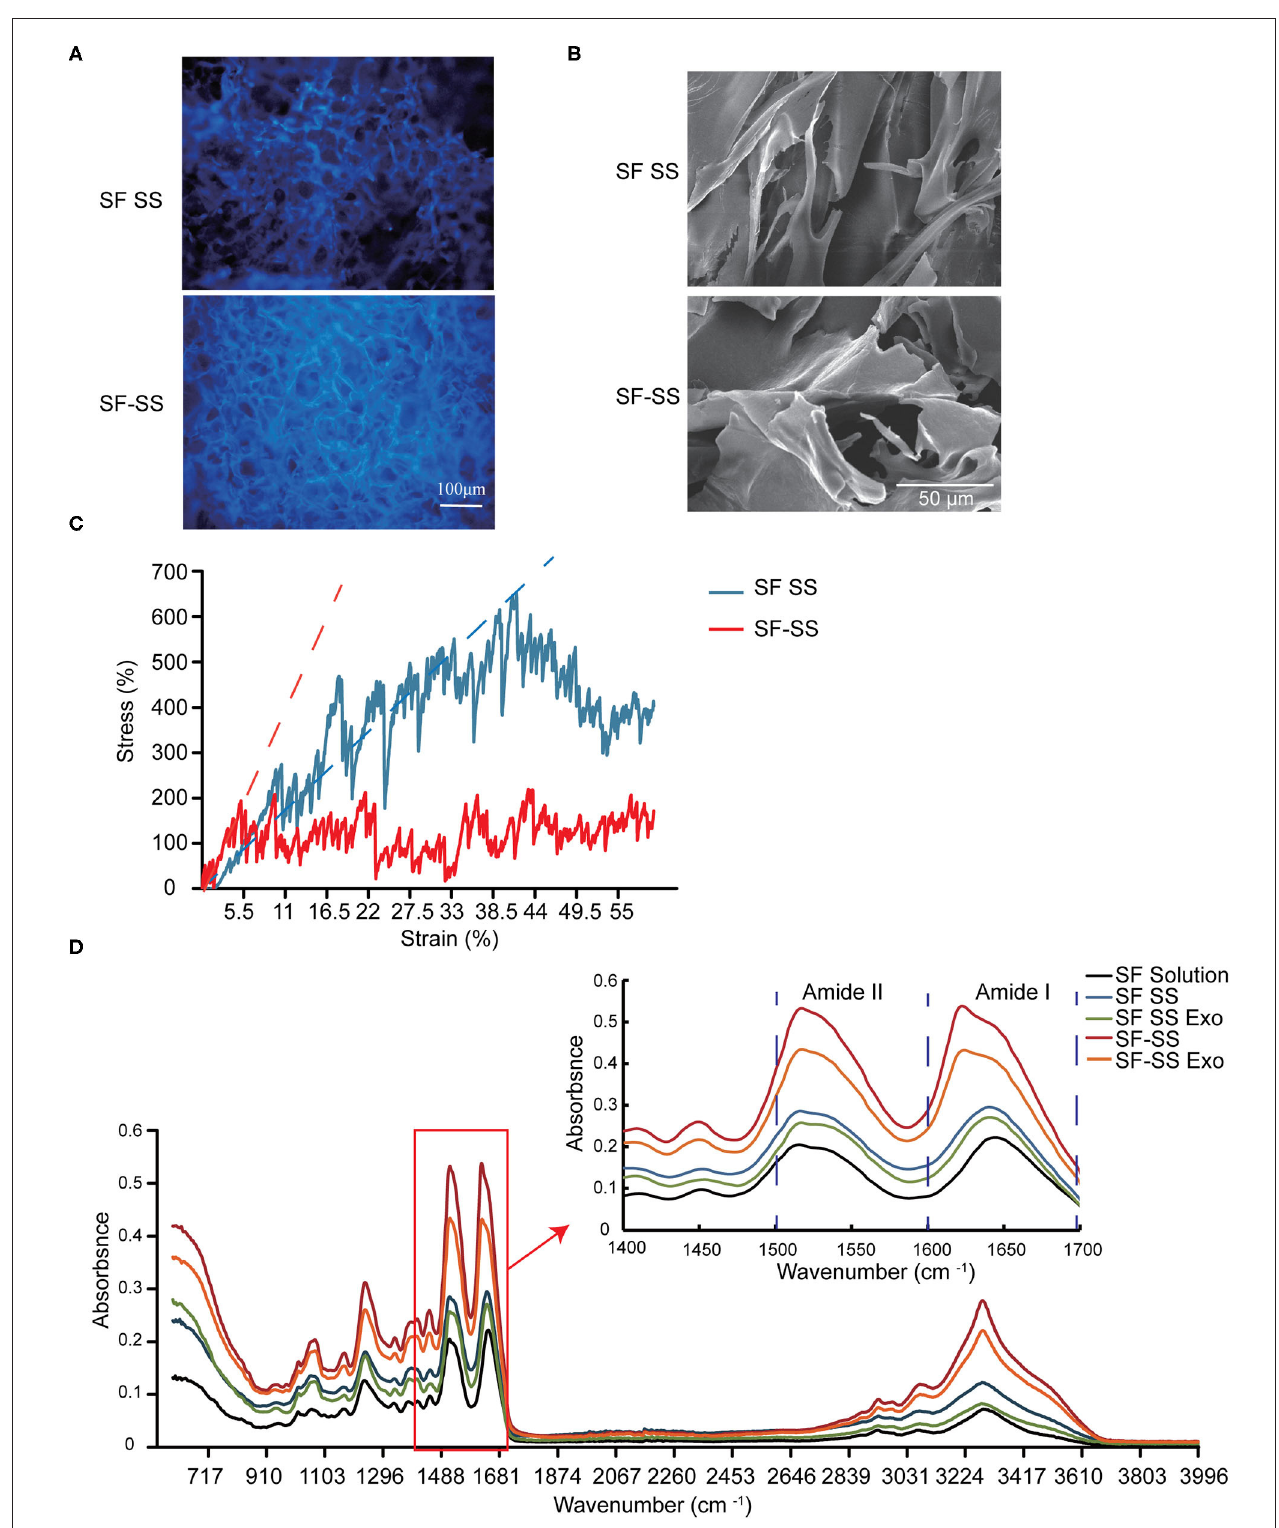
FIGURE 3 | Characterization of SF SS and SF-SS hydrogel. (A) Spontaneous fluorescence and microstructure of SF SS and SF-SS hydrogel. (B) Microstructure of SF SS and SF-SS hydrogel. (C) The stress-strain curve of SF SS and SF-SS hydrogel. (D) Fourier transform infrared spectroscopy of SF SS and SF-SS hydrogel.